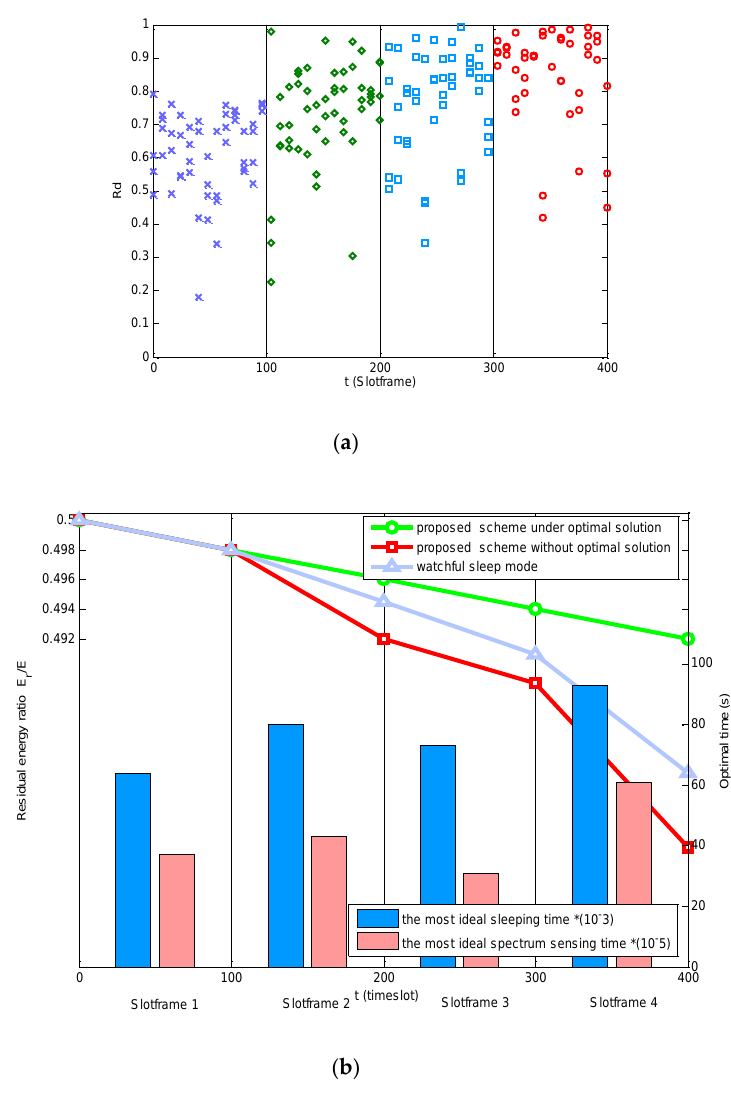
Figure 12. Joint energy saving in frequency and time domain . ( a ) Energy saving in frequency domain; ( b ) energy saving in time domain.